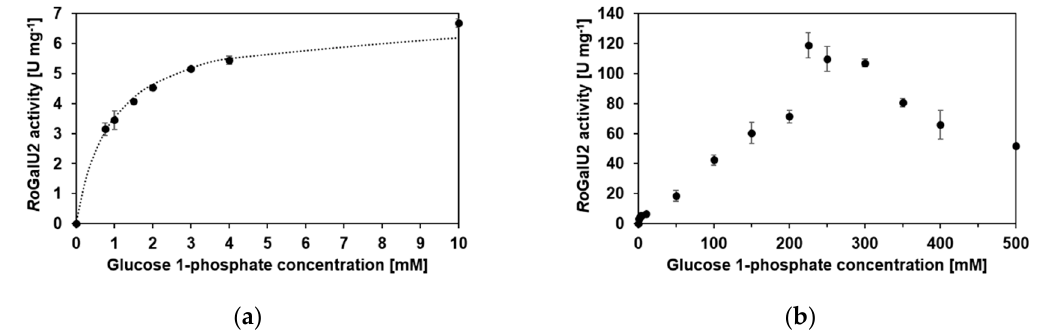
Figure 10. Ro GalU2 enzyme activity depending on the glucose 1-phosphate concentration between 50 µM and 500 mM at a fixed UTP concentration of 1.5 mM. Data for glucose 1-phosphate concentrations between 0 and 10 mM were fit to the kinetic model of Michaelis–Menten ( a ). The data obtained over the total glucose 1-phosphate variation are presented in ( b ), whereas no fit was able to describe the data. Assay mixture contained 0.05–500 mM glucose 1-phosphate, 1.5 mM UTP, 1 mM MgCl 2 , 50 mM Hepes bu ff er, pH 7.4, 1.7 µ g Ro GalU2. Reaction was carried out at 42 ◦ C in 1 mL volume. Means with standard deviations are shown from a minimum of triplicates.